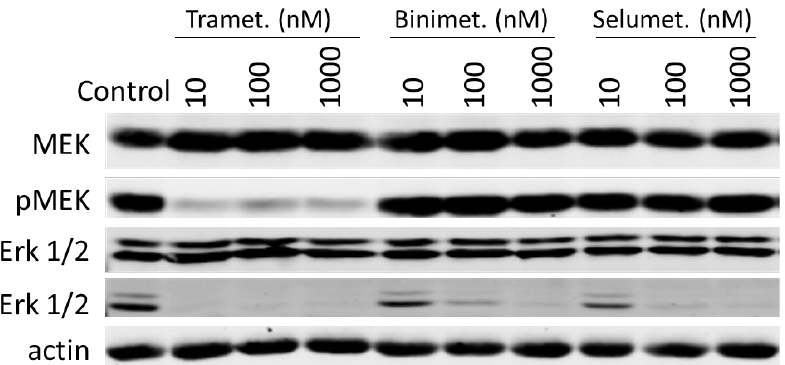
Figure 5. Effects of Mek inhibitors on Mek and Erk phosphorylation in MDA-MB-231 cells. MDA- MB-231 cells were treated with the indicated drugs for 1 h and the protein expression level and phosphorylation level of Mek and Erk were determined by Western blotting. Uncropped Western Blots and densitometry can be found at supplementary.